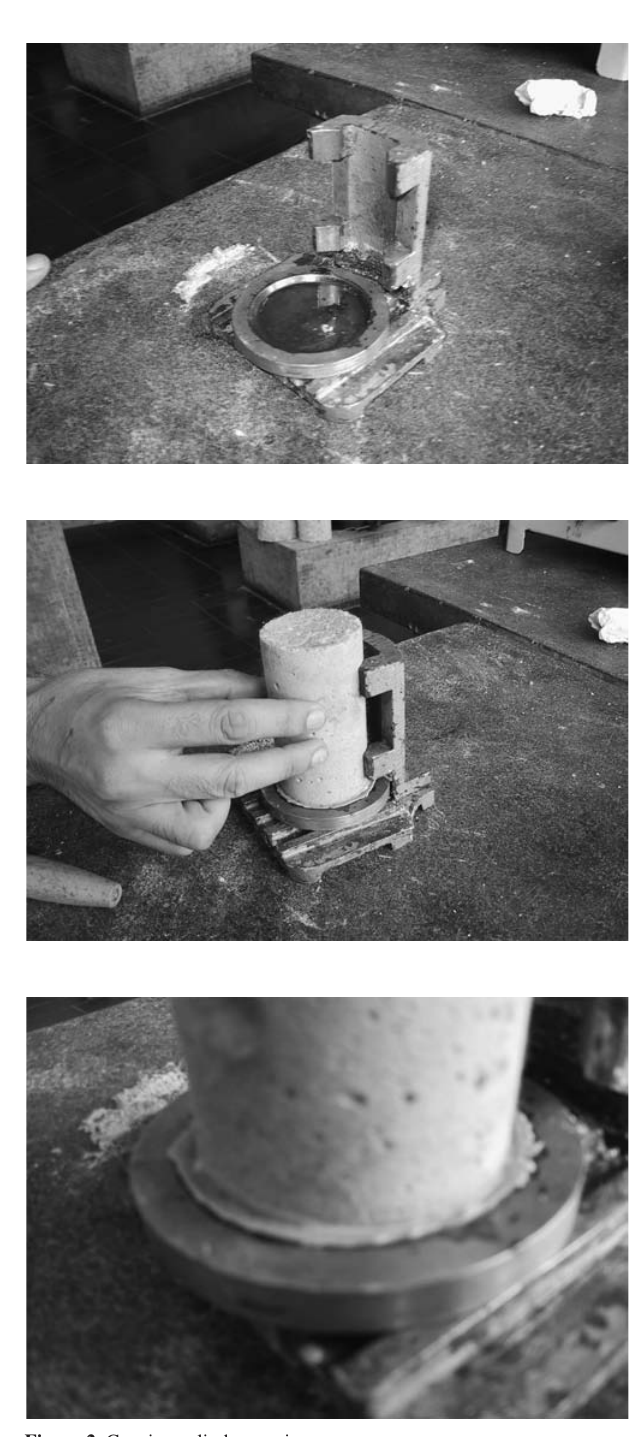
Figure 1. Compressive test specimens of Carbon fiber. Figure 2. Capping cylinder